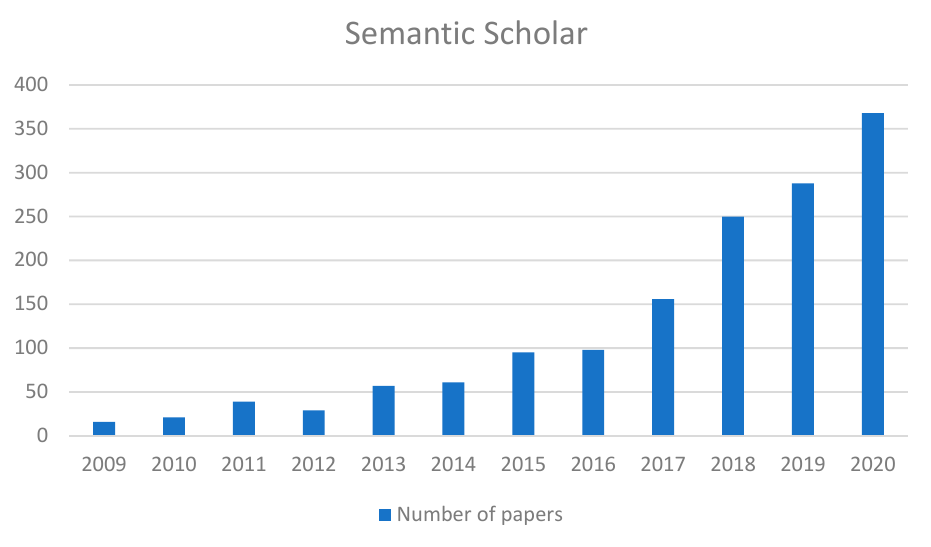
Figure 1. Statistics of the number of HEML papers by Semantic Scholar over the years.